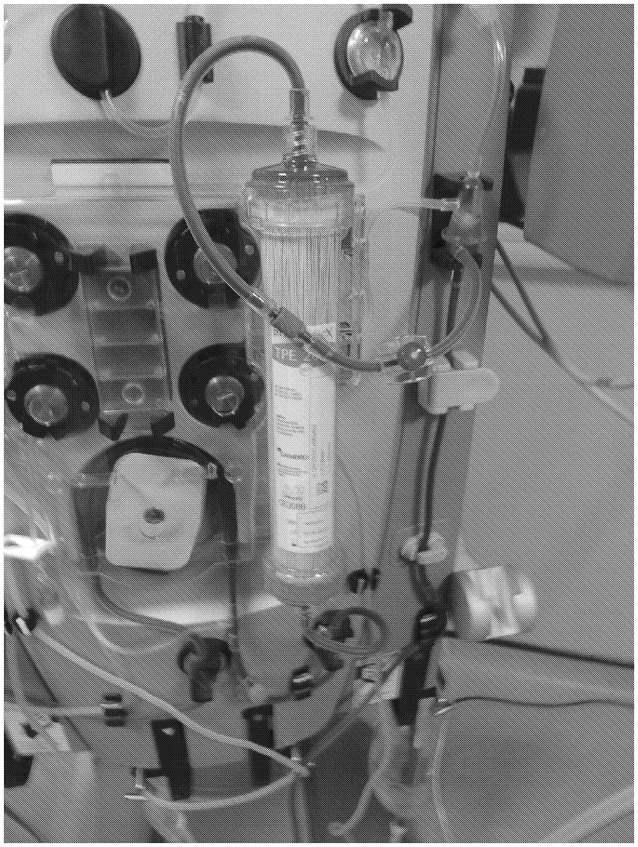
The extracorporeal plasma filtration system can be seen (Prismaflex® TPE 2000; Gambro).